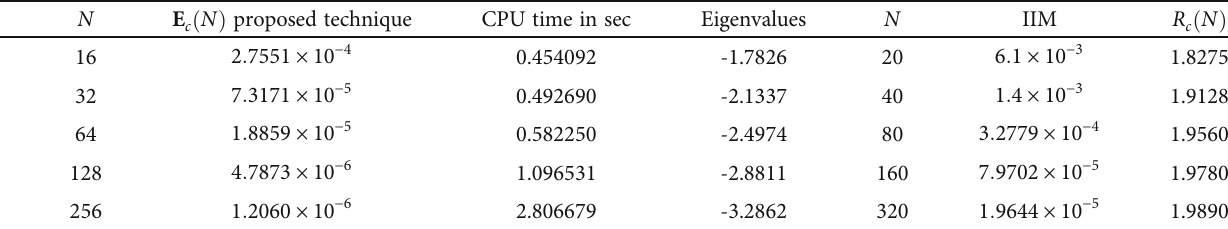
Table 1: Analysis of errors for Example 1.